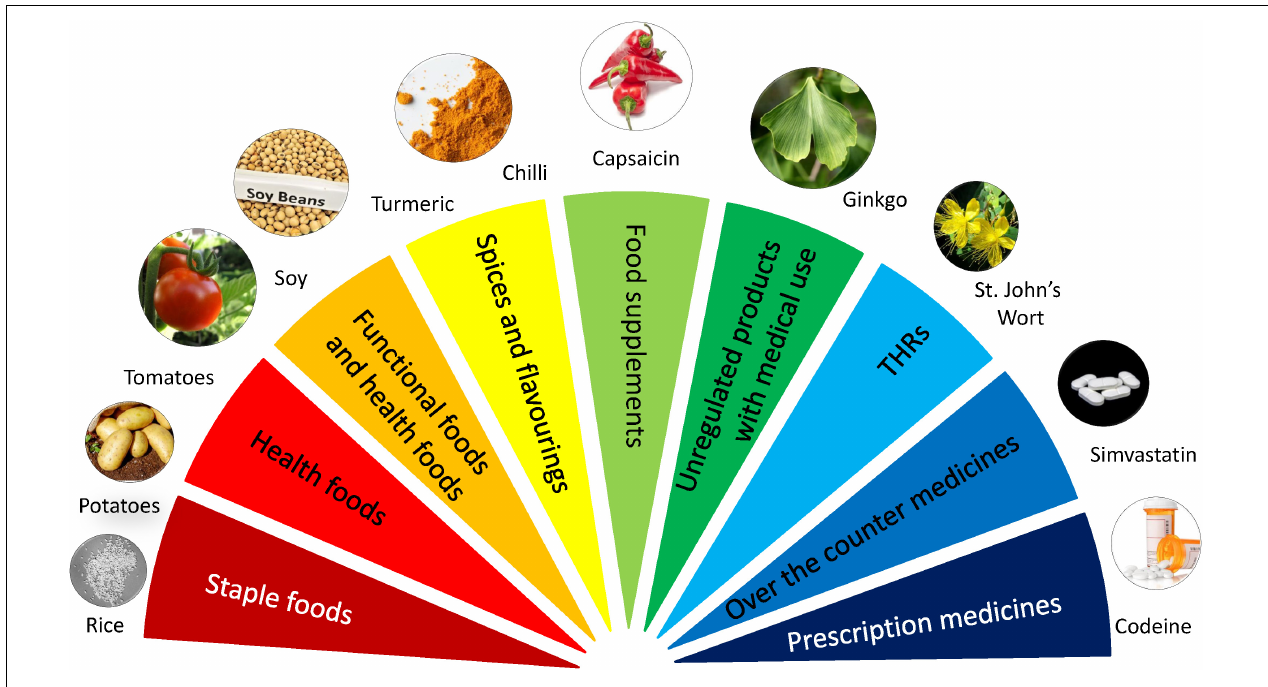
FIGURE 1 | The food-medicine interface: where to draw the line?